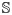
Pairwise similarity of the 5hmC measures Δβ(100), Δm∞ and Δh, in terms of the similarity coefficient S.Orange rectangles correspond to the values of S(Δβ(100),Δh), dark green dots to the values of S(Δβ(100),Δm∞) and brown rectangles to the values of S(Δh,Δm∞).